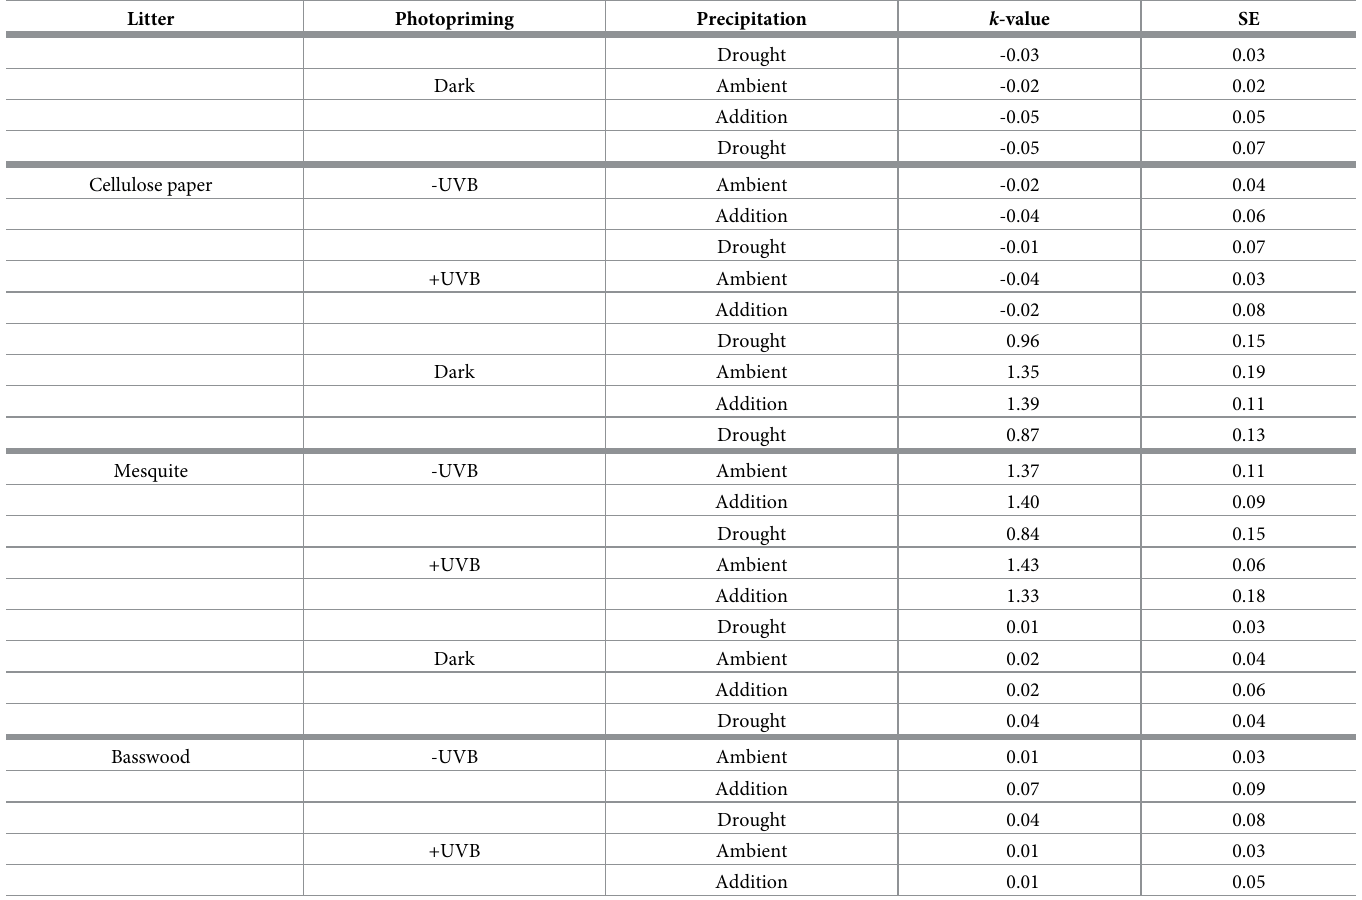
Table 1. Summary of mean decay constants (k-values) and associated standard errors (SE; ± ) estimated by fitting a single exponential decay function to litter mass loss data. Values are categorized by each litter type by photopriming by precipitation treatment combination used in the study.